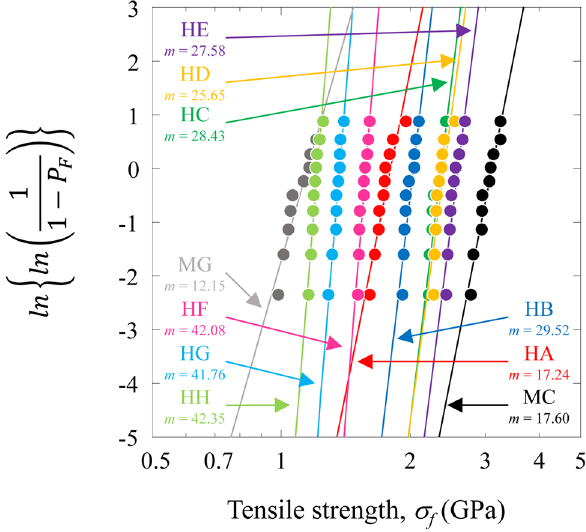
Figure 5. Weibull plots of the CFRP, GFRP, and HFRP